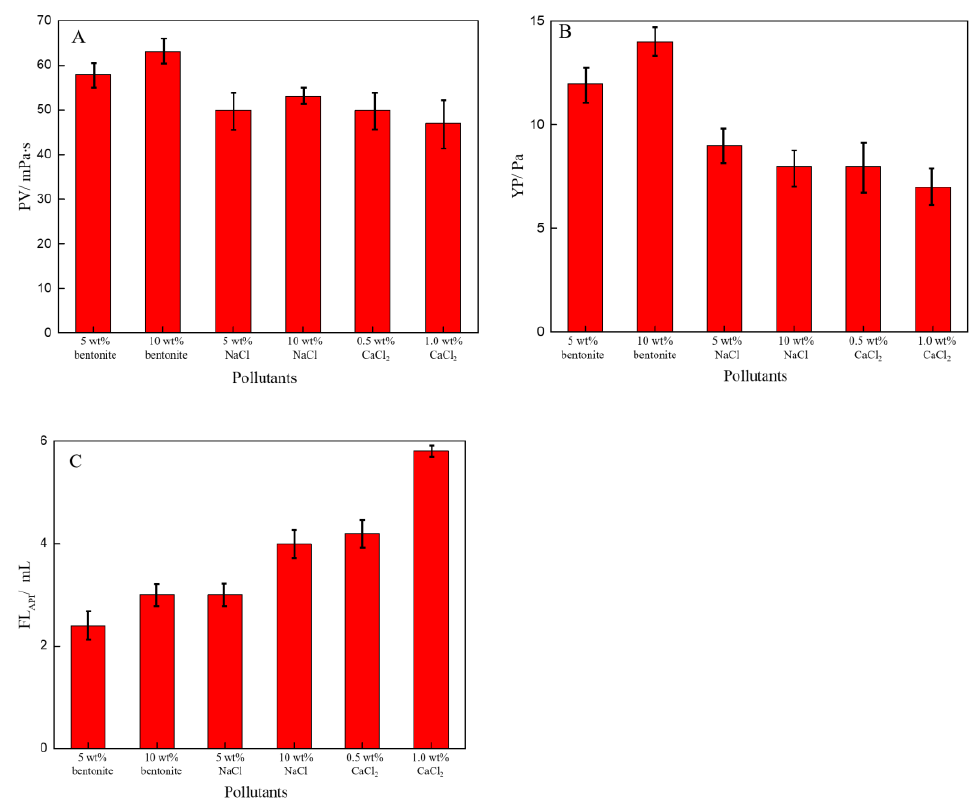
Figure 12. Effect of pollutants on the drilling fluid: ( A ) Plastic viscosity (PV), ( B )Yield point (YP), ( C ) FL API of the drilling fluid. Data were shown as mean ± s. e. m. (n 3, replicates).